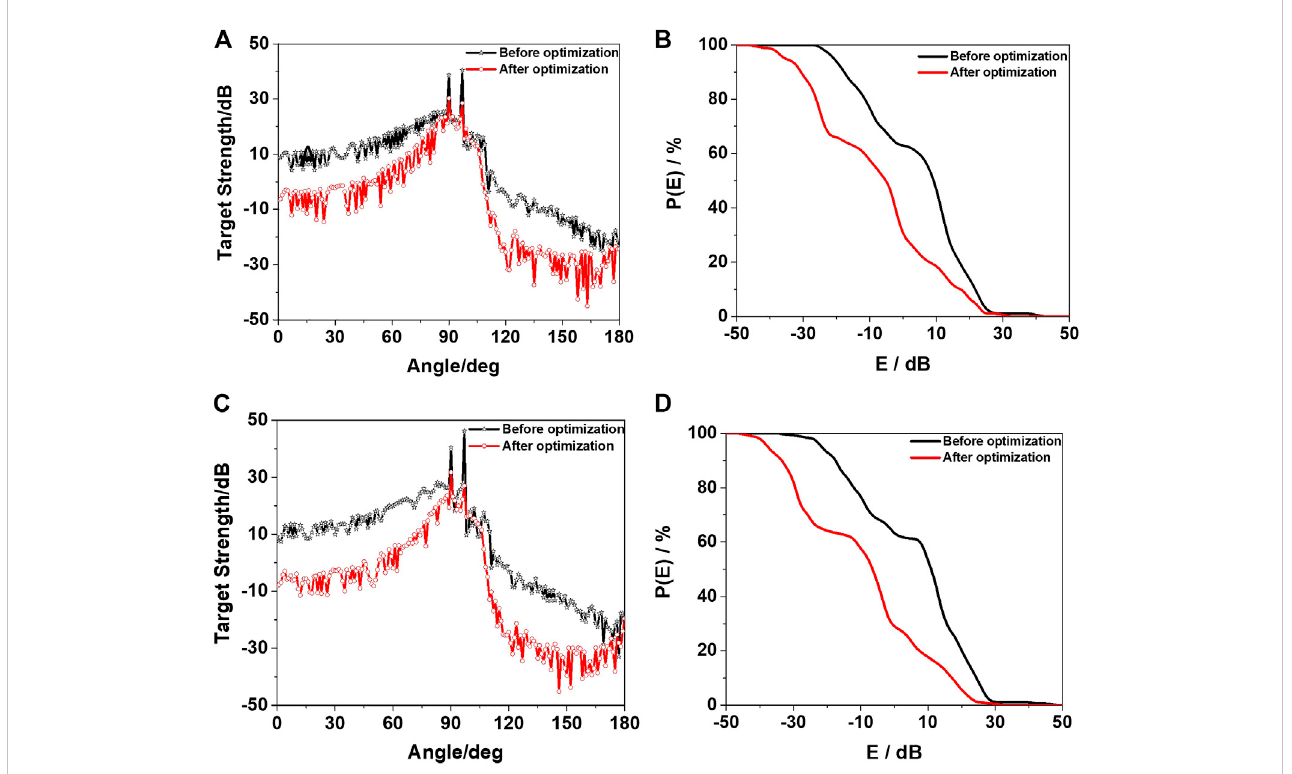
FIGURE 12 Comparison of azimuth characteristics and angle detection rate of TS of the assembly of the hull and conning tower before and after optimization. (A,B) are f = 5.0 kHz. (C,D) are f = 10.0